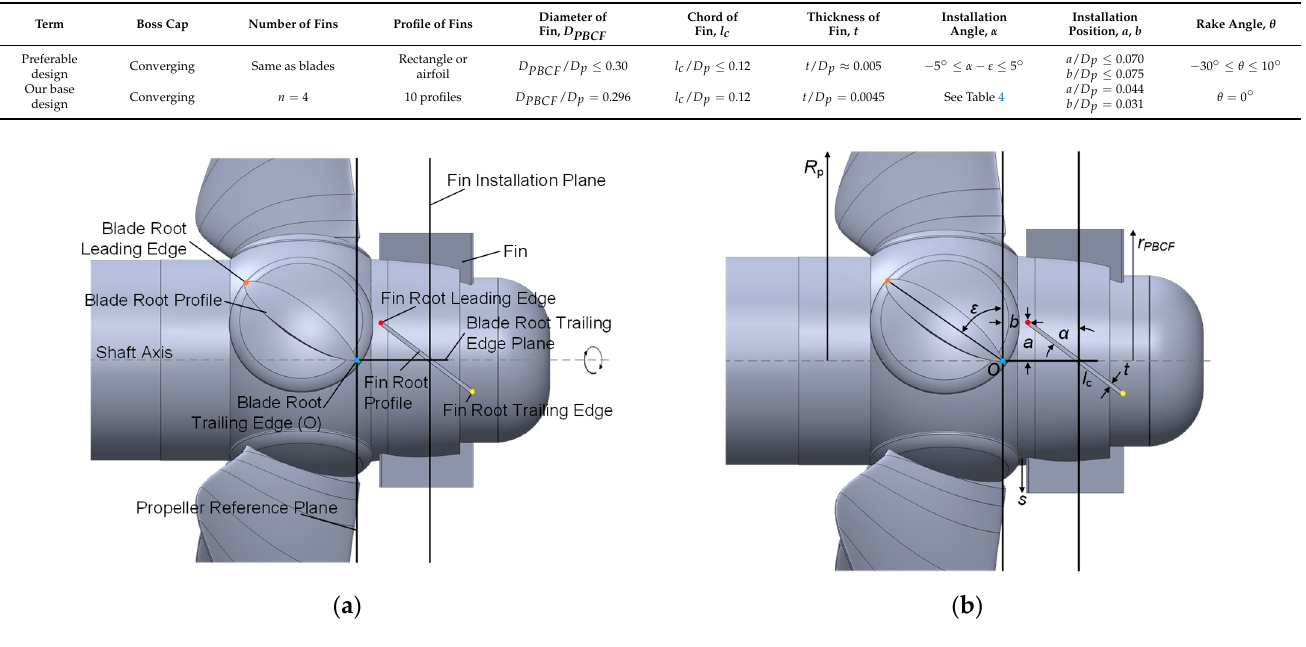
Figure 5. The model-scale propeller with rectangular PBCFs, in which all the key terminologies and design parameters are visually indicated. ( a ) Definition of profiles, axes, planes, and points. ( b ) Key PBCFs sizing and installation parameters.